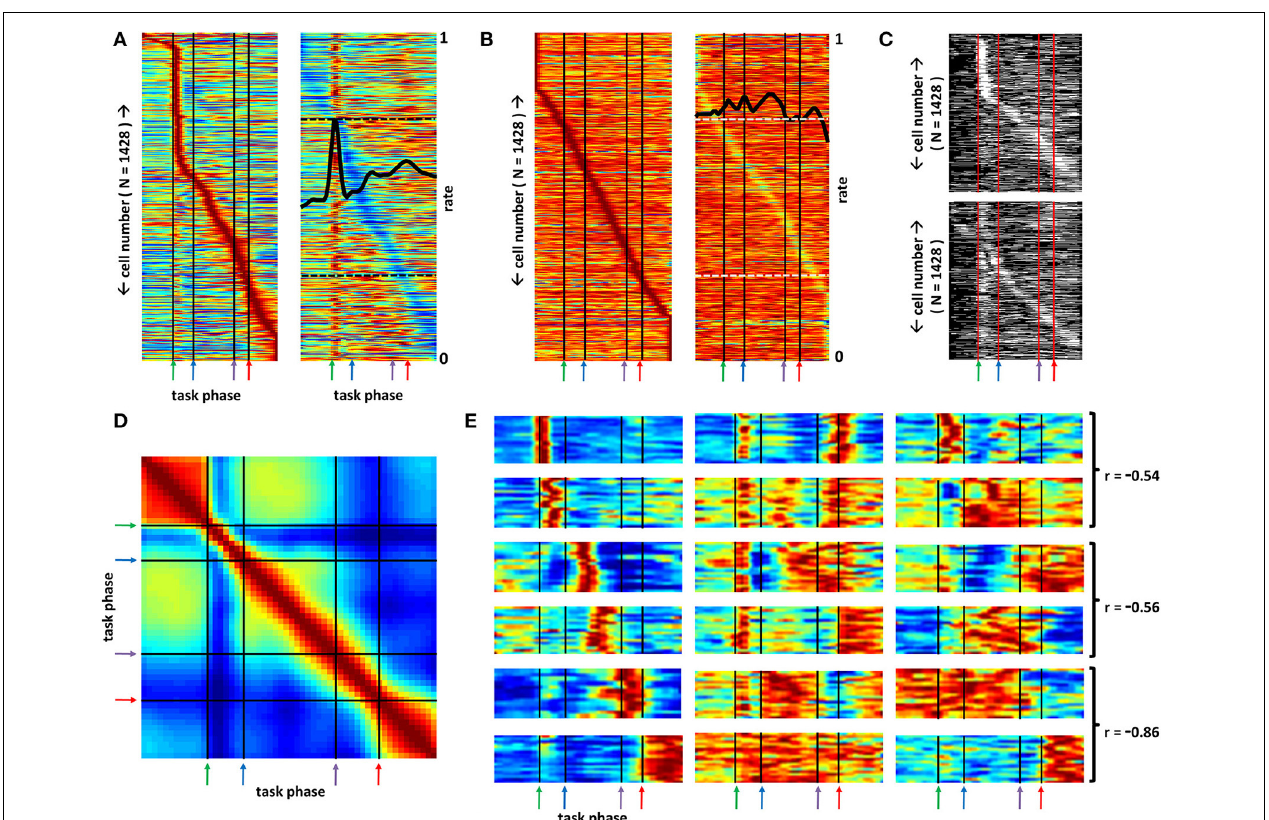
FIGURE 3 | Distinct sub-populations of basal forebrain neurons distinguish all phases of a selective attention task. (A) Left panel: Mean firing rates, each normalized to their own in-task maximum rate (blue-red = 0–1), of all recorded BF neurons (y-axis) across all phases of the task (x-axis). Green, blue, purple, and red arrows demark, respectively, the light flash, nose-poke, plate-cross and stop/reward phases of the task. Neurons are ordered according to the task phase associated with peak firing rate to demonstrate that large populations of neurons fire at their maximal rates for every task phase. Right panel: Maximum-normalized rate vectors for the same neuron population, but organized according to the task phase associated with lowest rate. The mean, peak-normalized firing rate of all neurons is given by the overlaid black trace (see right side of panel for scale; dashed black lines mark 0.25 and 0.75 on this axis). This rendering permits visualization of the multiple peaks and troughs in firing observed for many neurons. (B) Mean maximum-normalized firing rate vectors for the same set of neurons as in (A) , but generated using randomly chosen light-onset times (blue-red = 0–1). The full set of rate vectors has been reordered according to the task phase at which neurons exhibit their peak (left panel) and trough (right panel) firing rates (early peak neurons at top, late peak neurons at bottom) such that individual neurons in (A) and (B) will occupy different positions on the associated y-axes. Under these conditions, the maximum mean firing rates observed are much closer to the mean rates across all task phases such that these panels contain many more values near the firing rate maximum (i.e., more orange and red bins). Left panel and right panel depict the same data organized according to time of peak and trough firing,